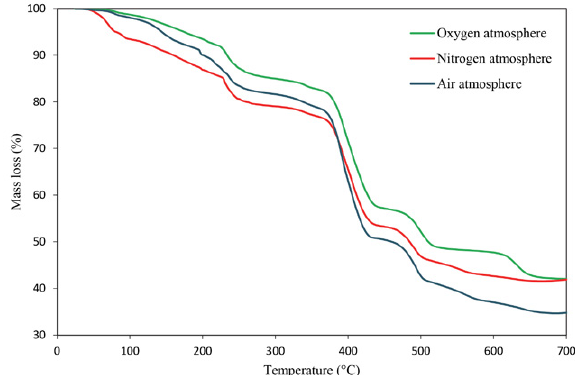
Figure 2: Mass loss of Nd(NO 3 ) 3 · 6H 2 O in N 2 , O 2 and air atmos-